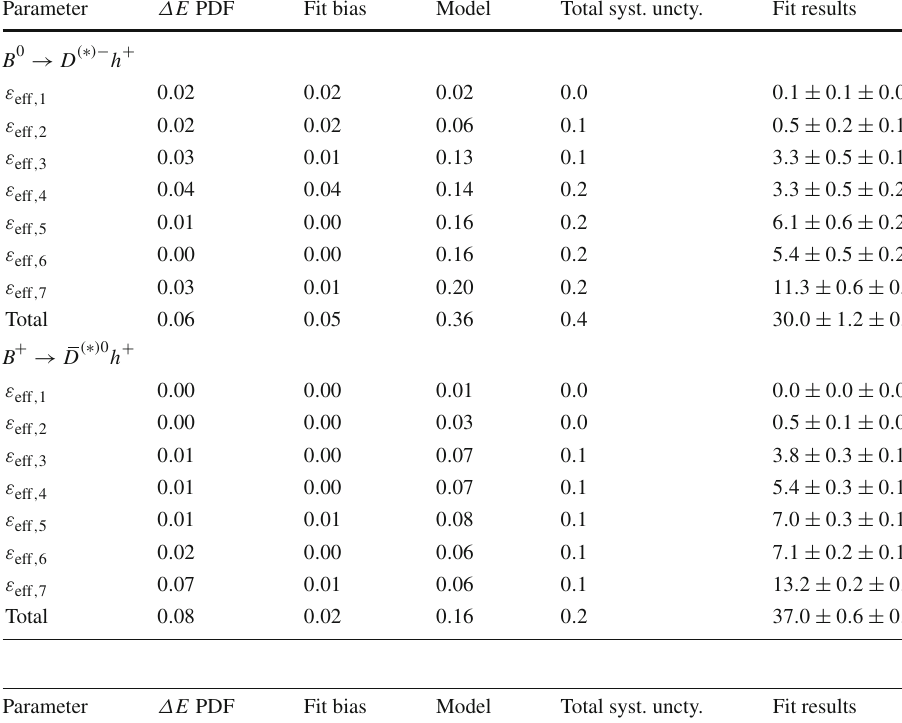
Table 8 Effective efficiencies for the DNN tagger: systematic uncertainties associated with the Δ E parametrization, fit bias, and fit model, and total systematic uncertainty are shown together with the fit results (with stat. and syst. uncertainty). The results are given in